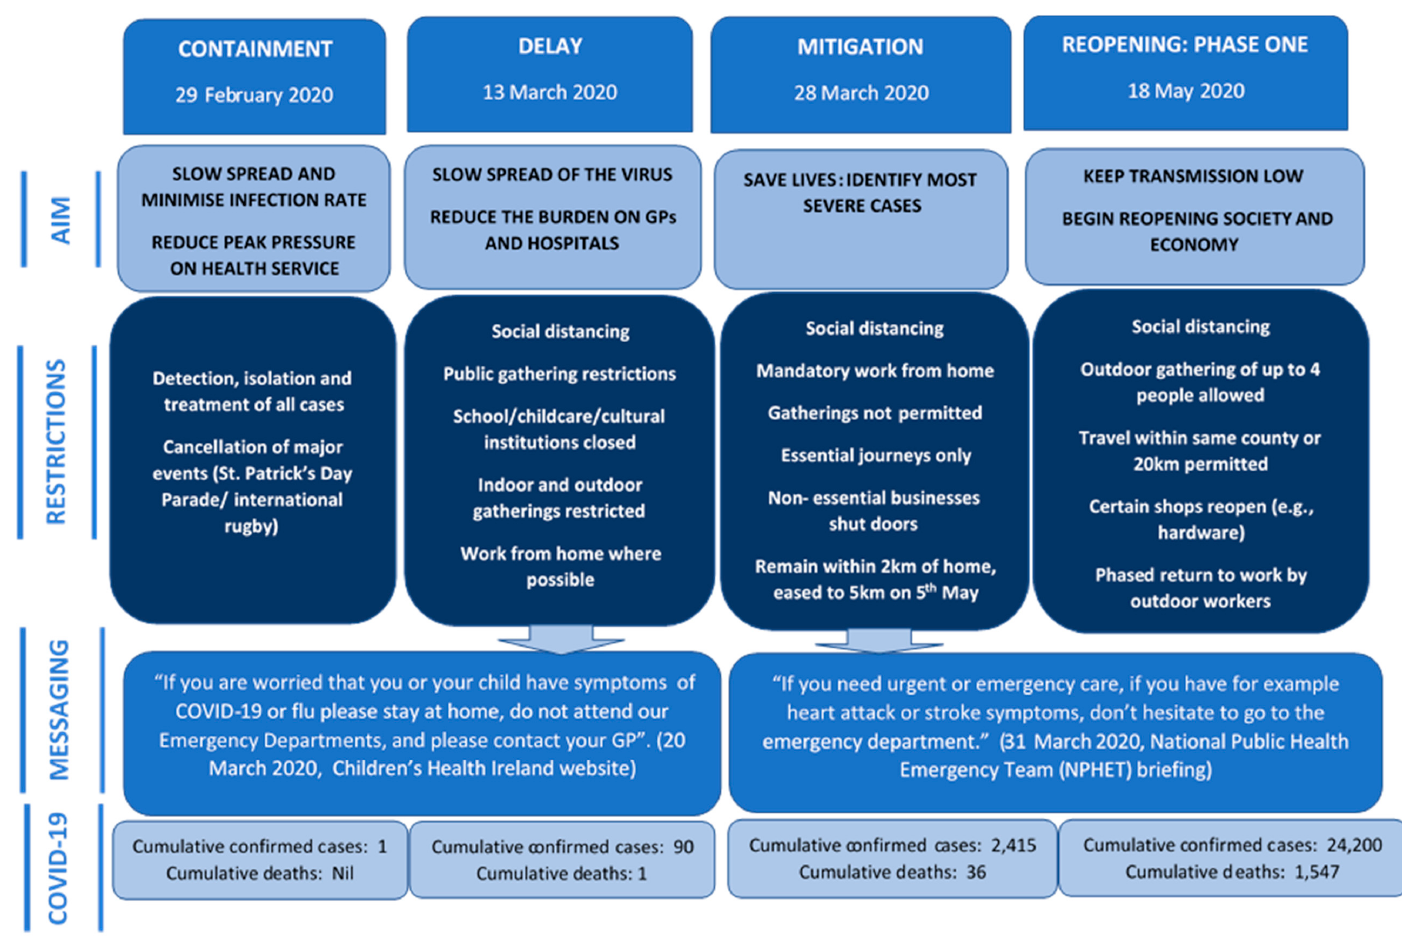
Figure 1. Public health stages of COVID-19 response.